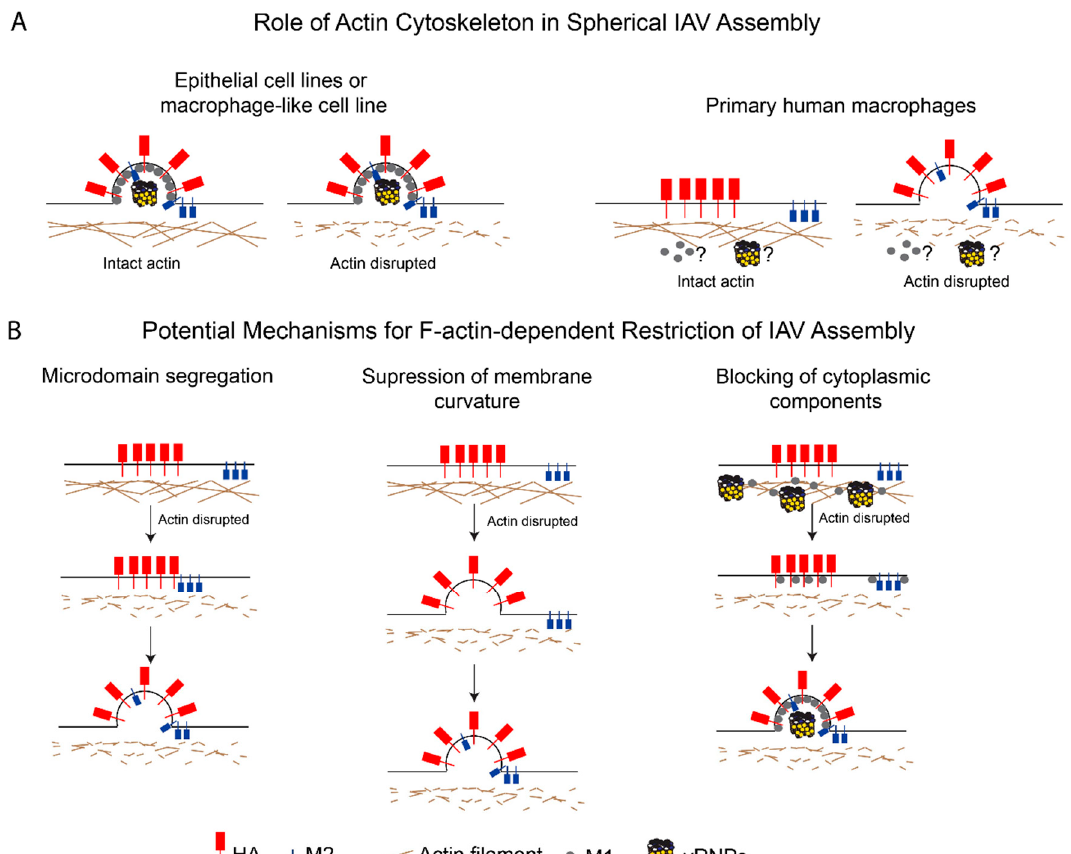
Figure 2. The role of the actin cytoskeleton in spherical IAV assembly in host cells. ( A ) Contrasting roles for the actin cytoskeleton in spherical IAV assembly in different cell types. In IAV-permissive cells, such as epithelial cell lines and a macrophage-like cell line, the actin cytoskeleton either promotes or has no effects on IAV particle production. In contrast, the actin cytoskeleton restricts HA-M2 association and spherical IAV assembly in primary human macrophages. ( B ) Proposed mechanisms by which actin restricts spherical IAV assembly in primary human macrophages. Microdomain segregation : F-actin partitions HA- and M2-enriched plasma membrane microdomains. Suppression of membrane curvature : F-actin restricts HA-mediated curvature induction at the plasma membrane, which is required for M2 recruitment to the assembling particle. Blocking of cytoplasmic components : F-actin restricts trafficking and incorporation of other curvature-inducing structural components, that is, M1 and vRNP, to virus assembly sites.